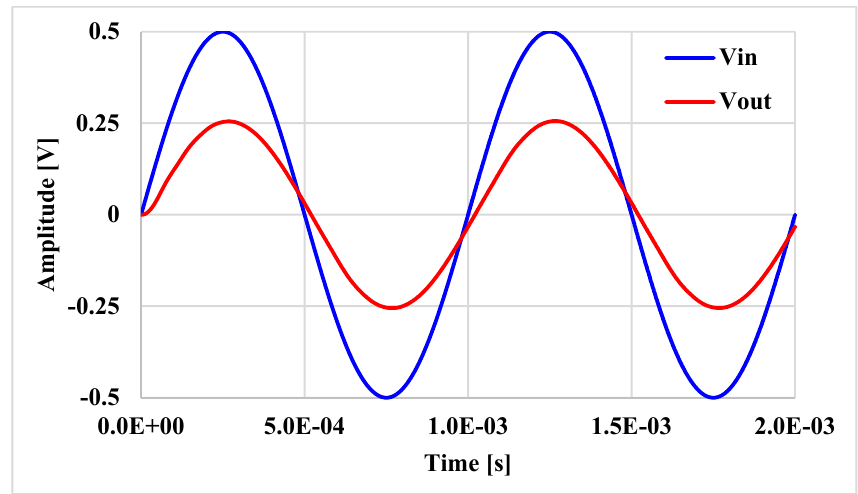
Figure 28. The frequency responses of the LP ladder filter with different R set .